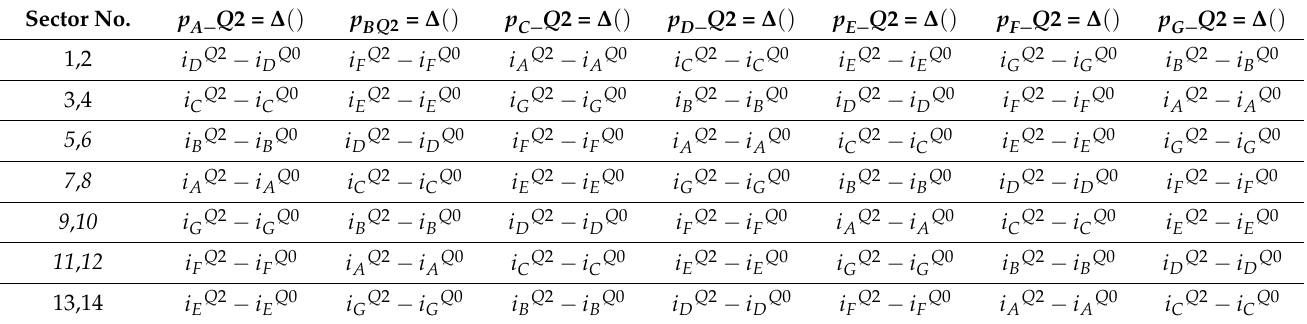
Table 4. Saliency position scalars in each sector of the seven-phase PMSMs using Q 2 (case = 1). Sector